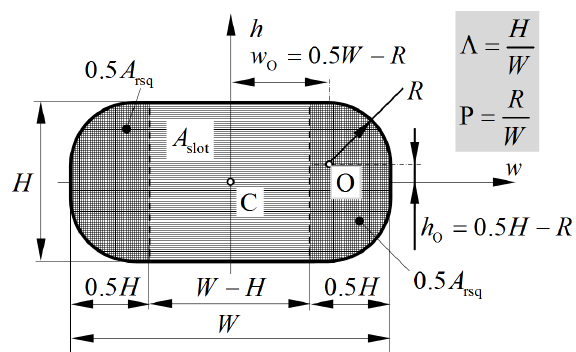
Fig. 2 Basic parameters of cross sectional area and idea it division into two basic